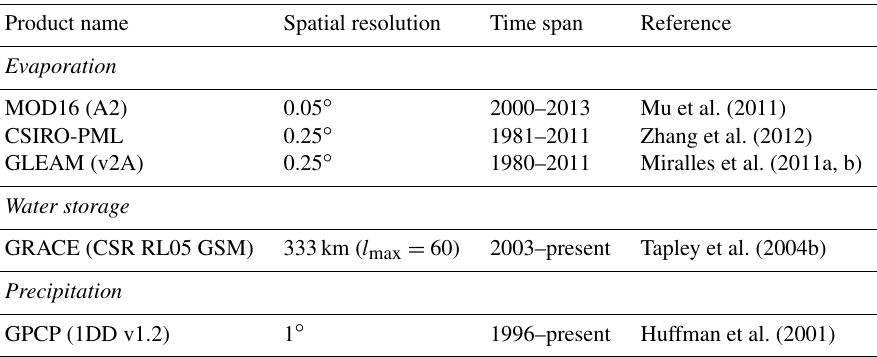
Table 1. Description of the satellite products used in this study. The temporal resolution is daily except for MOD16 (8-daily) and GRACE (monthly). The original MOD16 product is available at 1km resolution in the sinusoidal projection. In this study, the product was reprojected onto a 0.05 ◦ regular grid using the MODIS Reprojection Tool